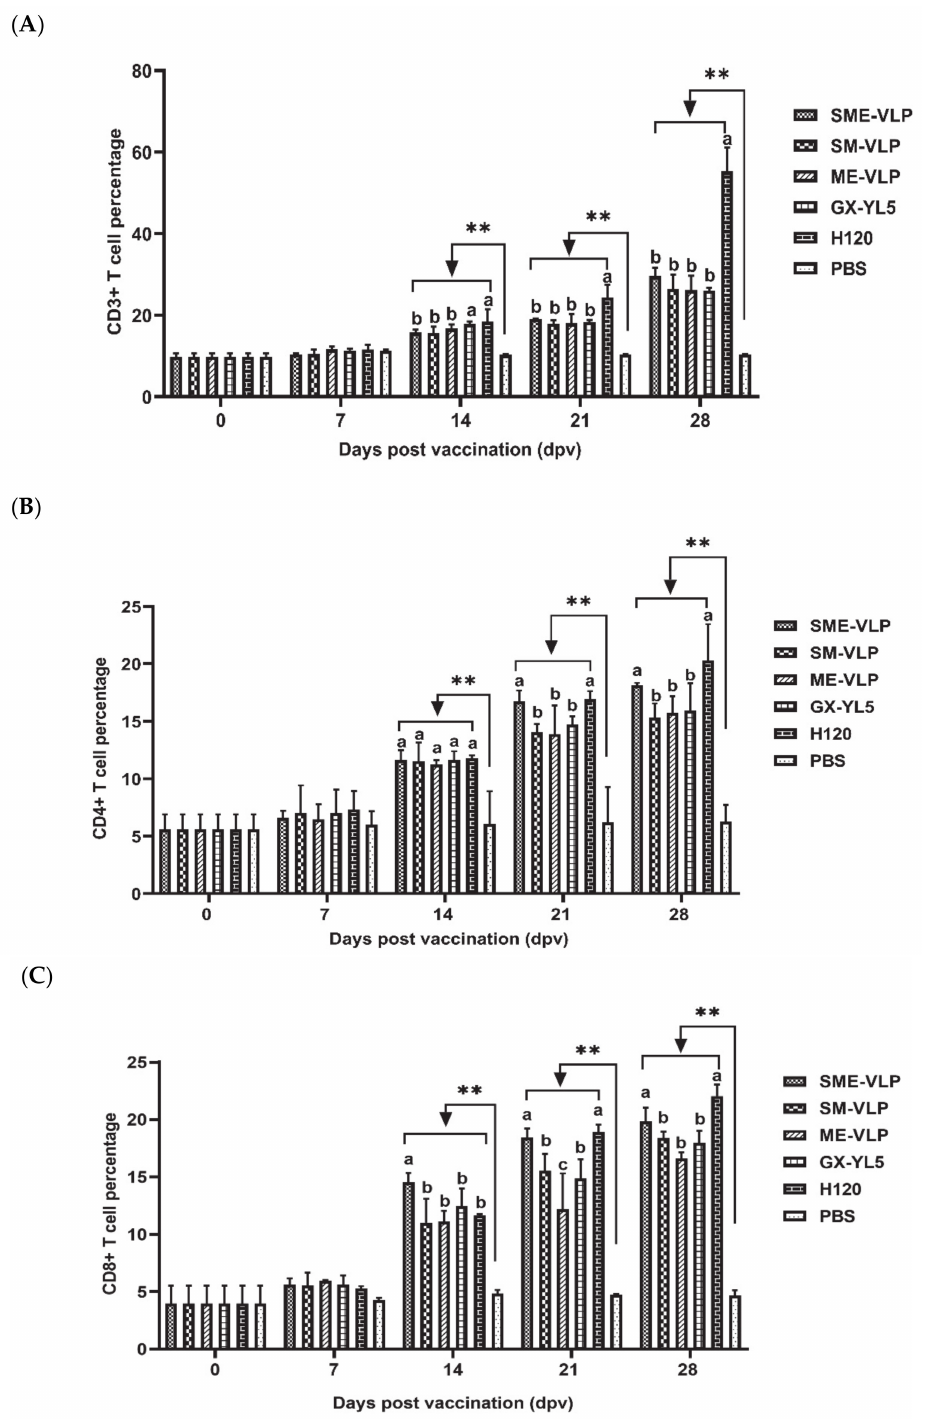
Figure 8. Percentages of CD3 + , CD4 + and CD8 + T lymphocytes in peripheral blood of vaccinated chickens. Peripheral blood lymphocytes were isolated from vaccinated chickens at 0, 7, 14, 21 and 28 dpv and analyzed by flow cytometry. ( A ) Percentages of CD3 + T lymphocytes. ( B ) Percentages of CD4 + T lymphocytes. ( C ) Percentages of CD8 + T lymphocytes. Letters (a–c) indicate significant differences among vaccinated groups ( p < 0.05). ** indicates p < 0.01 between vaccinated and nonvaccinated groups. ( n = 10